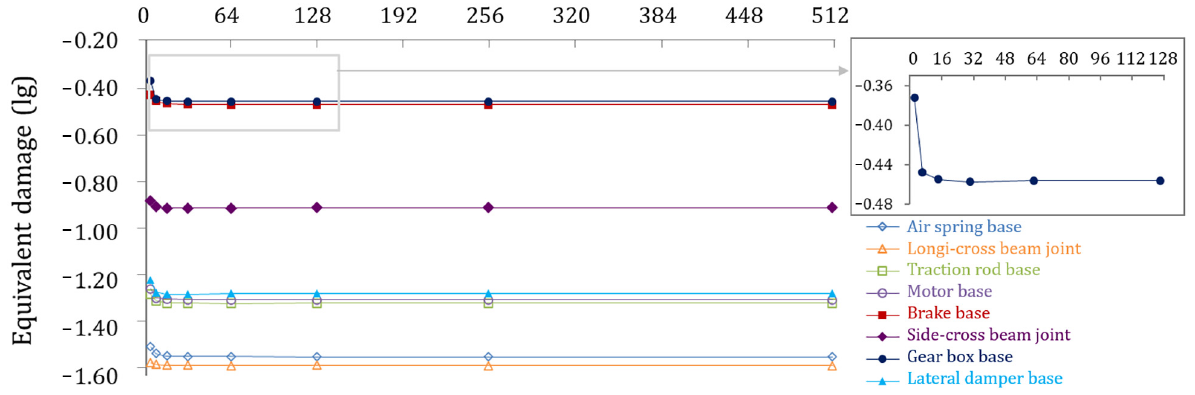
Figure 14. Load spectrum classification of 8 loading position types.